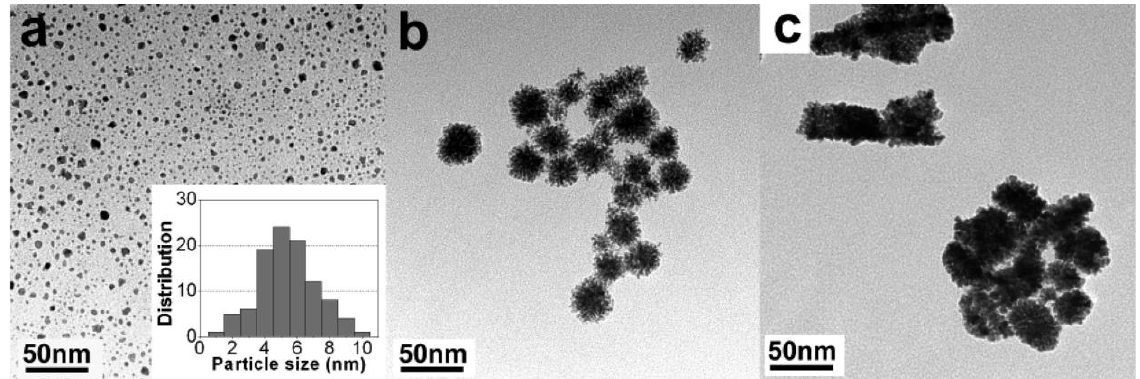
Figure 7. TEM images of the Pt nanostructures at different current densities: ( a ) 5; ( b ) 20; and ( c ) 40 mA.cm −2 . The inset in panel a is the particle size distribution of the monodisperse Pt nanoparticles [13].